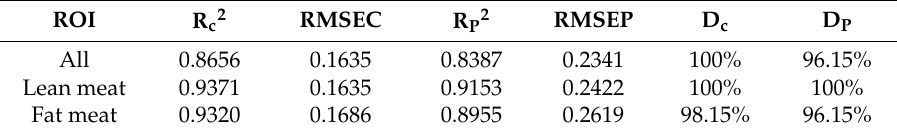
Table 2. Multiple linear regression (MLR) modeling result statistics for Cantonese sausage degree with NIR spectra using selected wavelengths extracted by successive projections algorithm